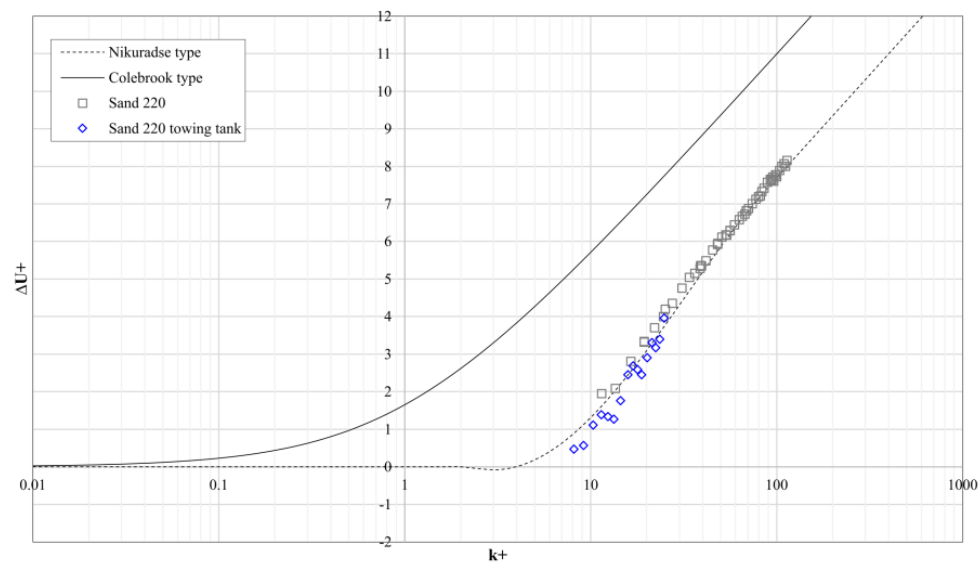
Figure 9. Experimental roughness function of the Sand 220 surface developed from FTFC pressure drop measurements and from towing tank tests in [24].